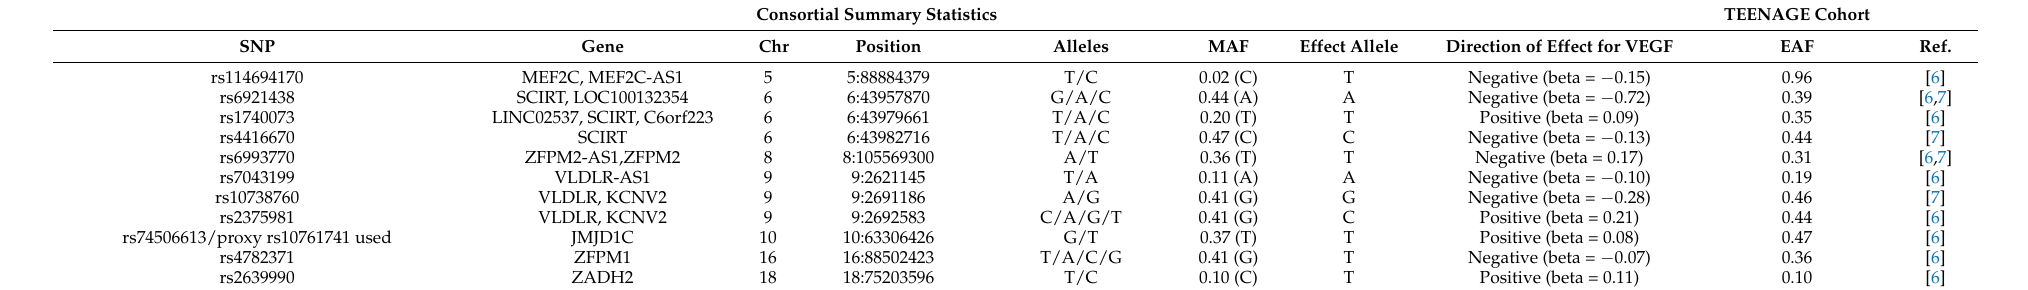
Table 1. List of the VEGF-A-related single-nucleotide polymorphisms (SNPs) ( n = 11) investigated for cardiometabolic associations in the TEENAGE